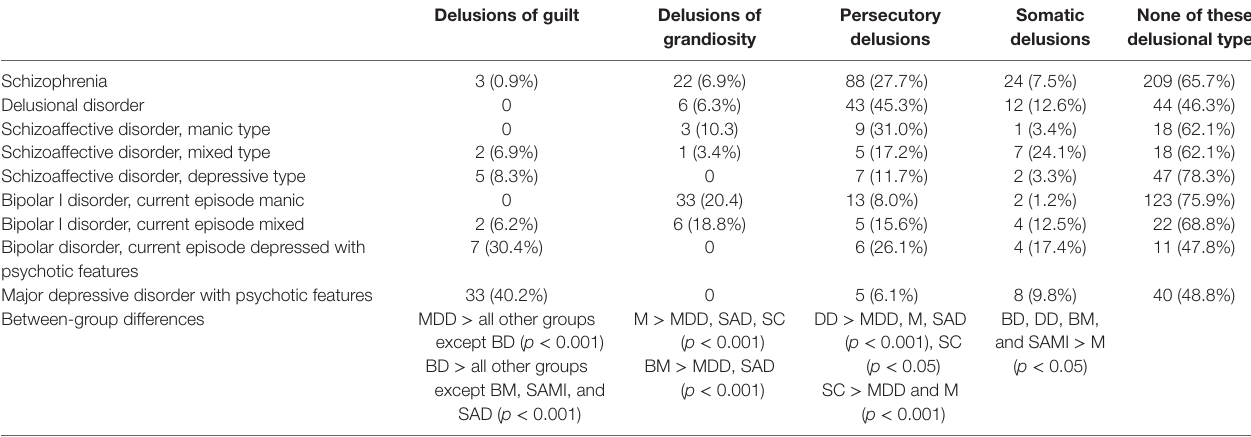
Table 2 | Presence of specific delusional themes by diagnostic